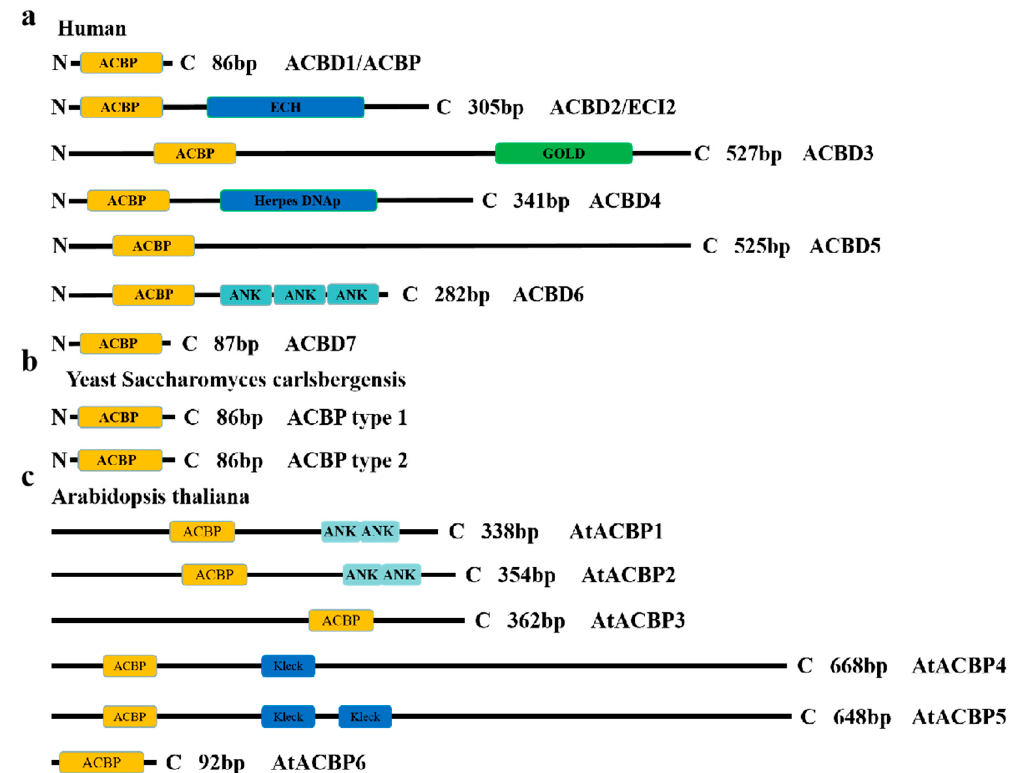
Figure 1. Schematic of key sequence domains of ACBP family proteins in humans, yeast S. carlsbergensis , and A. thaliana . All ACBP family proteins contain the ACBP domain, which binds to acyl-CoA ester. ( a ) There are seven kinds of ACBP family proteins in humans; ( b ) two kinds in yeast S. carlsbergensis ; and ( c ) six kinds in A. thaliana .